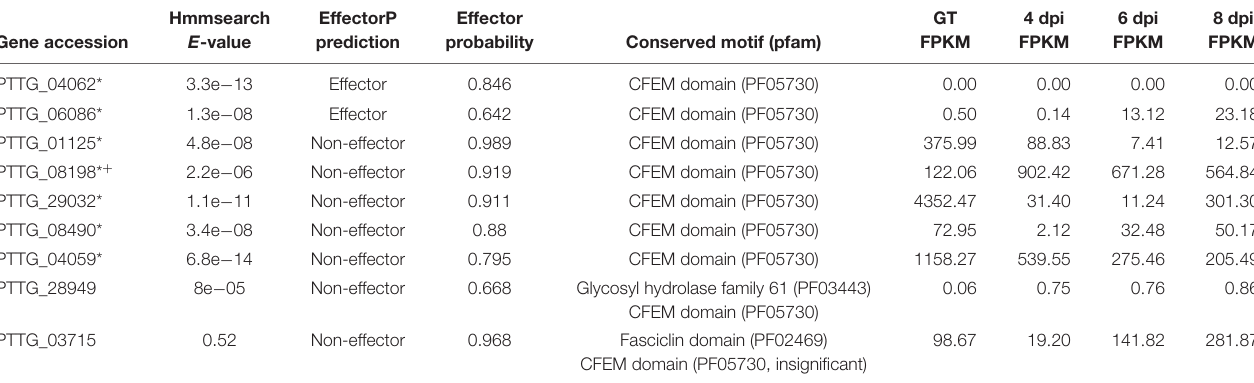
TABLE 2 | Genome-wide identification of secreted proteins with CFEM conserved motif from the wheat leaf rust fungus. Hmmsearch